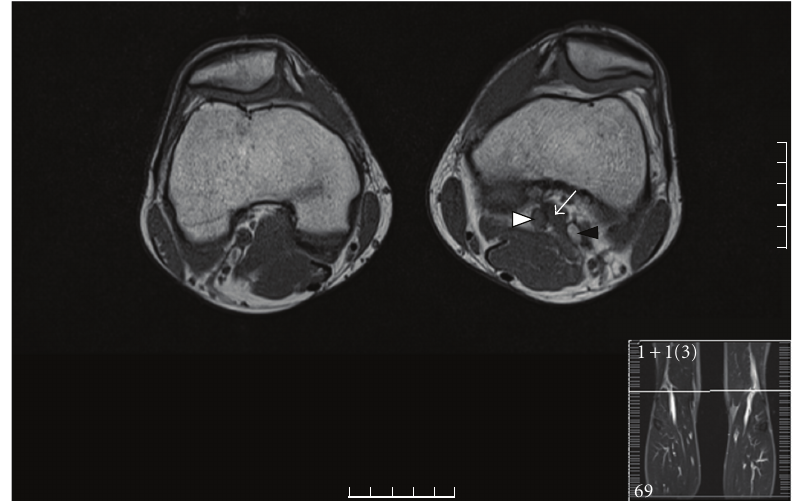
Figure 2: Axial T1-weighted MRI images through both knees at the level of the popliteal fossa showing the medial head of the gastrocnemius muscle (white arrow) going between the popliteal artery (white arrow head) and vein (black arrow